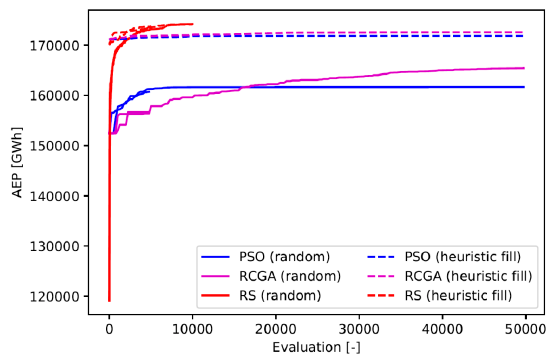
Figure 11. Evolution histories of the best solutions in different runs of PSO (particle swarm optimization), RCGA (real-coded genetic algorithm), and RS (random search).